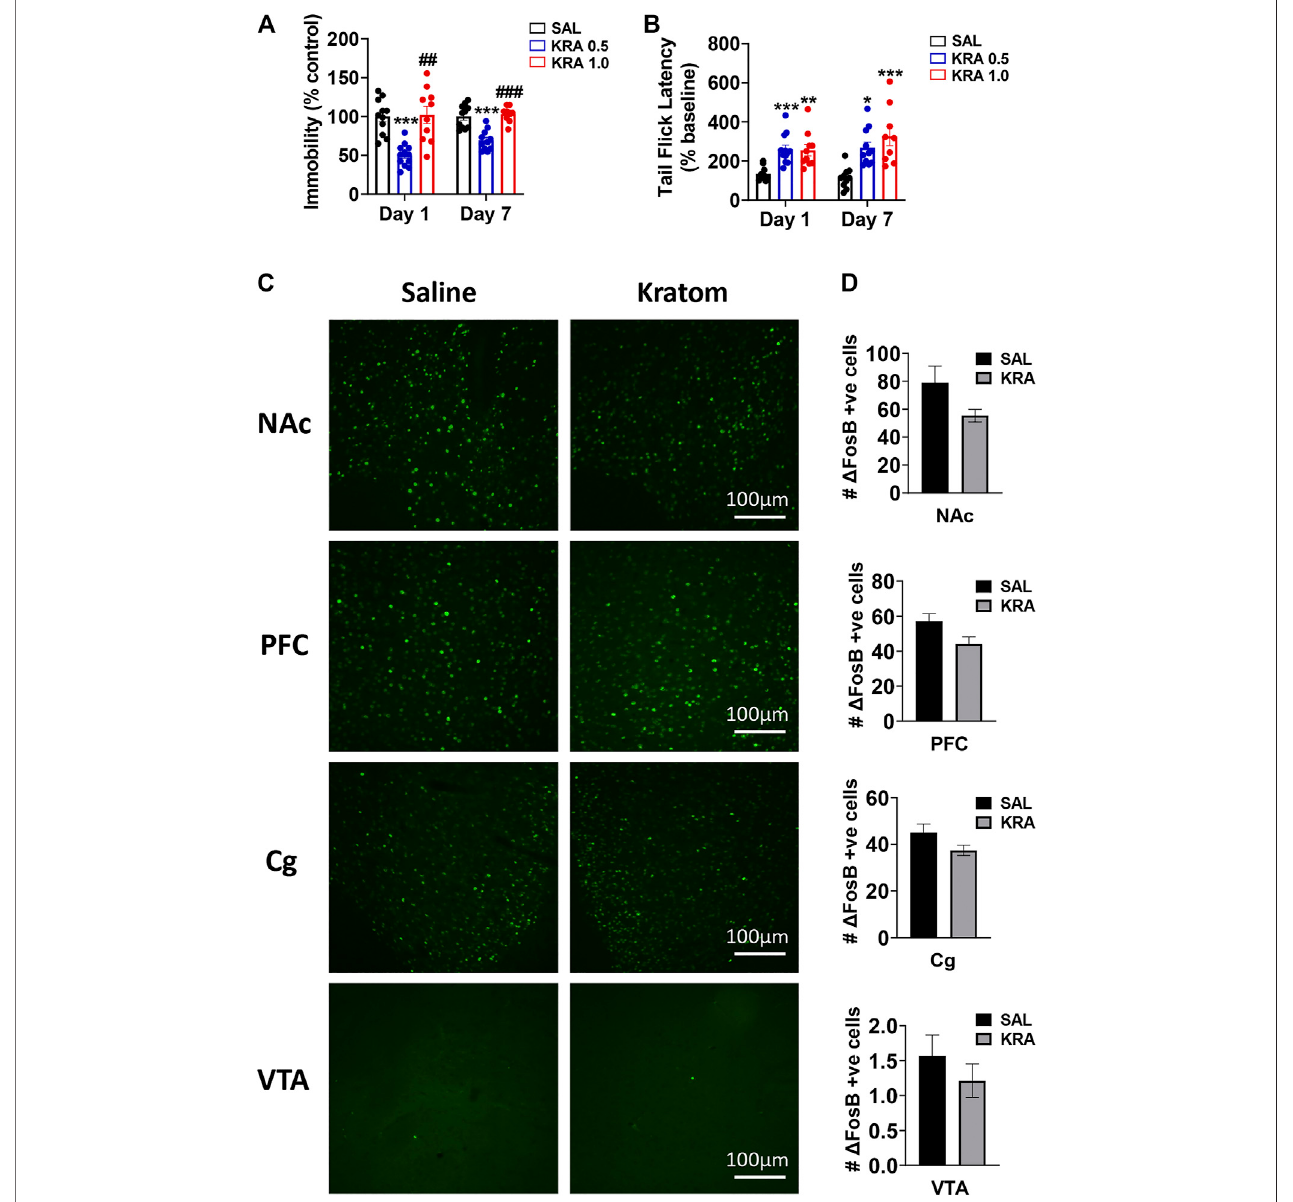
FIGURE 8 | Effects of kratom on behaviour and Δ FosB expression in rats. (A) Low (0.5 mg/kg) dose, but not high (1 mg/kg) dose kratom signi fi cantly reduced immobility time in the FST 30 min post-injection on both day 1 and day 7. (B) Both doses of kratom signi fi cantly increased tail- fl ick latencies compared to pre-drug baseline latencies 40 min post-acute and repeated injections. N (cid:2) 10 – 13 rats per group. (C,D) Representative images and quanti fi cation depicting no change in Δ FosB expressioninresponsetohighdosekratominanybrainregion. N (cid:2) 7-8ratspergroup.Barsrepresentmean ± sem.* p < 0.05,** p < 0.01,*** p < 0.001comparedto saline control rats. ## p < 0.01, ### p < 0.001 compared to low dose kratom treated